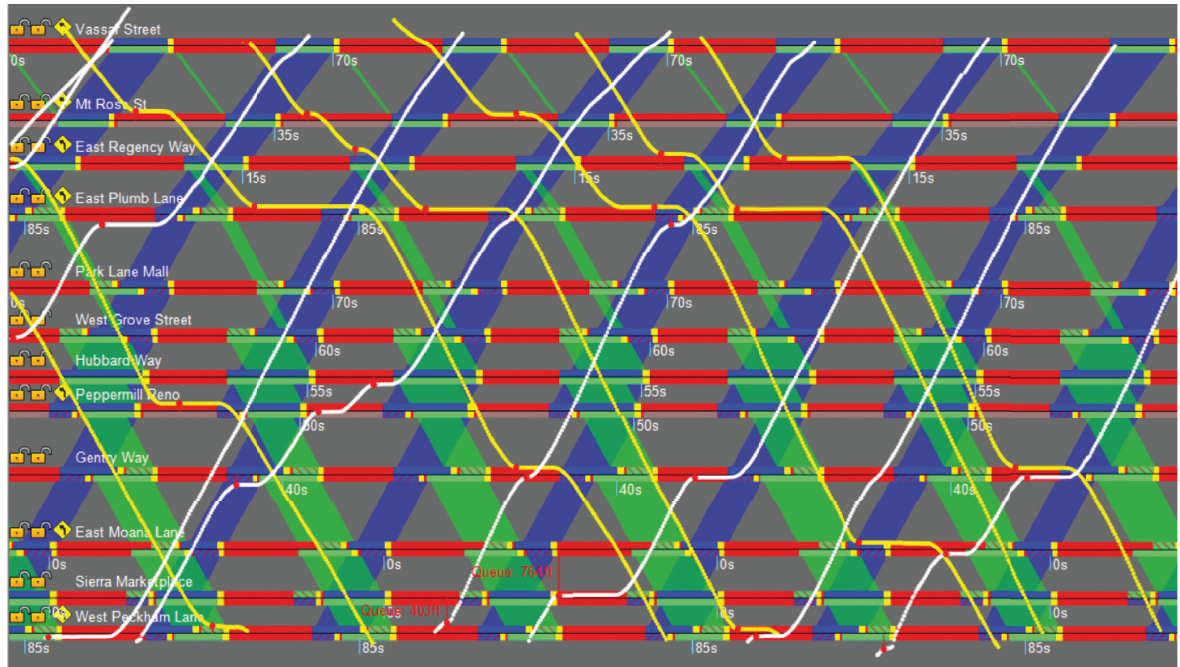
Figure 12: Vehicle trajectories under signal coordination. Table 1: Performance results under free operation and signal